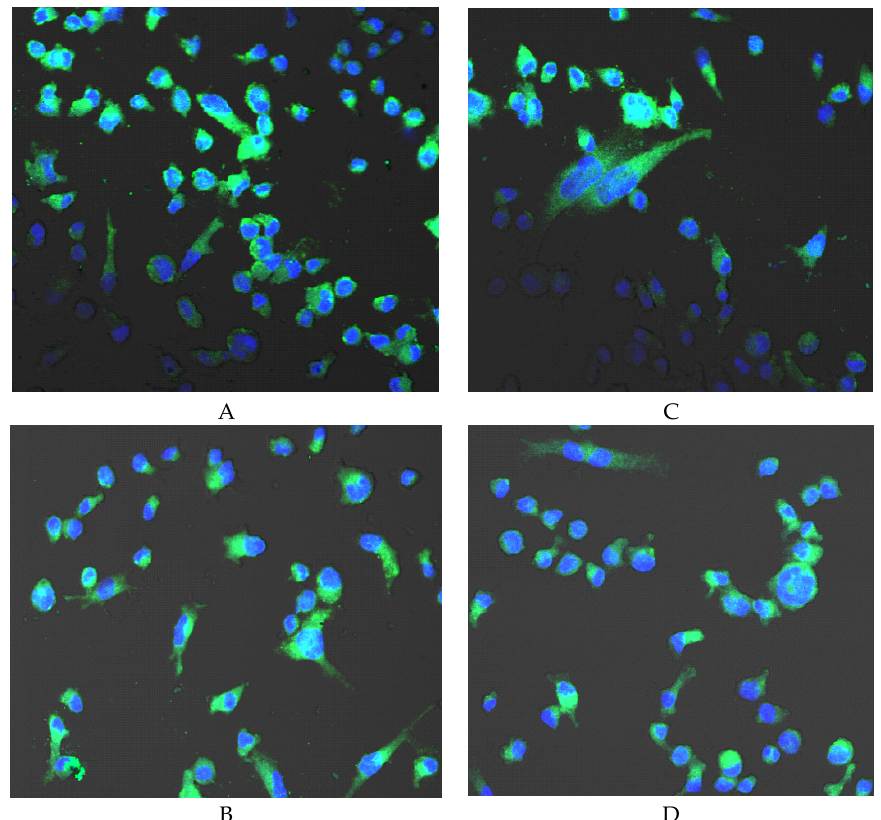
Figure 10. Imaging of COX-1 enzyme expression by fluorescence microscopy in macrophages cultured with Biodentine TM . Cells were cultured in RPMI medium with 10% FBS—control condition for 24 h ( A ) and for control condition for 48 h ( B ); macrophages cultured in RPMI medium with 10% FBS with Biodentine TM for 24 h ( C ) and for 48 h ( D ). The immunohistochemistry was performed using specific primary antibody, mouse anti-COX-1 (the overnight incubation at 4 ◦ C) and secondary antibodies conjugated with fluorochrome-anti-mouse IgG-FITC (incubation for 45 min at room temperature), enzyme expression visible as green fluorescence indicate COX-1 expression. The nuclei of cells were DAPI stained. Image analysis was performed with a confocal microscope using filters 38 HE GFP for green fluorescence and 49 DAPI for blue fluorescence. Objective magnification 20 × , computer zoom 2 × . Experiments were conducted as six separate assays (each assay in three replicates). No di ff erences in enzymes protein expression were observed p ≤ 0.5 (U-Mann Whitney test).